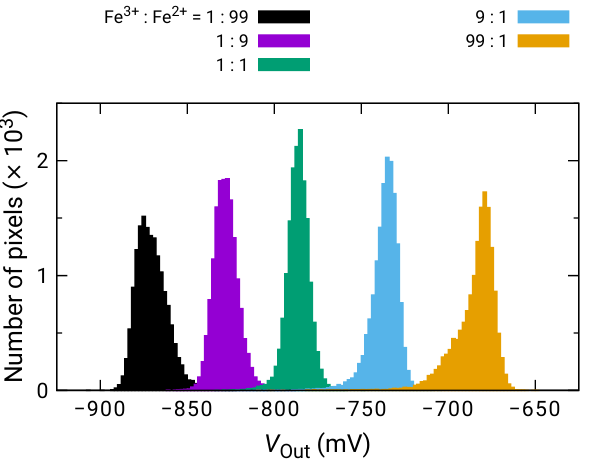
Figure 4. Histogram of V Out for various ratio between K 3 Fe(CN) 6 (Fe 3 + ) and K 4 Fe(CN) 6 (Fe 2 + ).